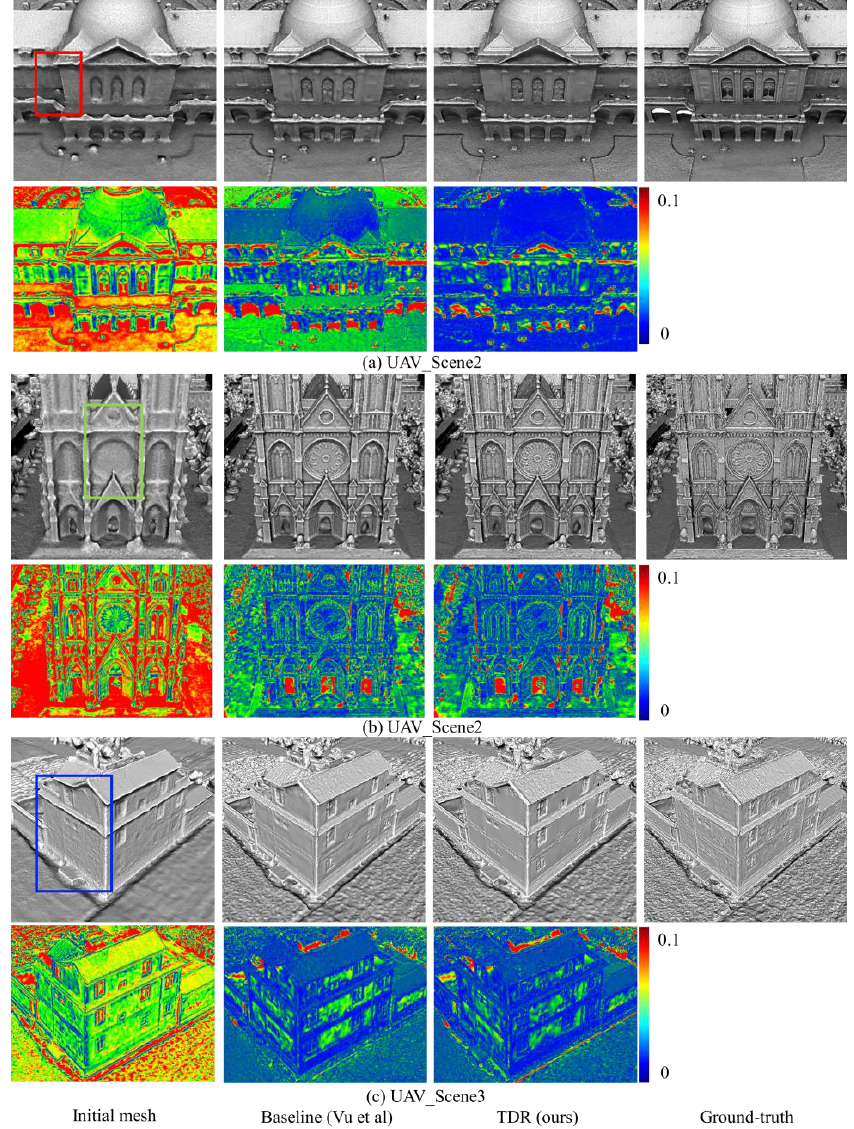
Figure 7. The meshes result (odd rows) and the error ( d i → R ) distributions of the meshes (even rows) on the BlendedMVS dataset.